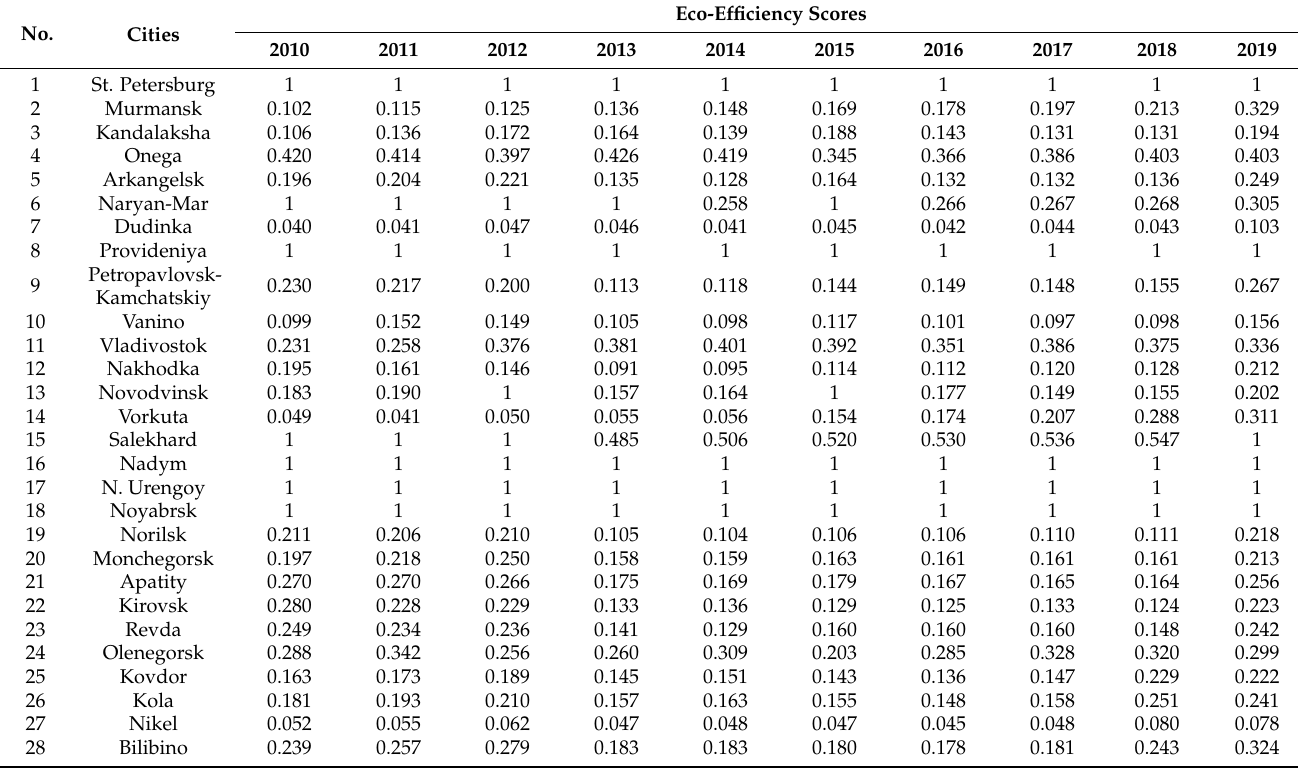
Table 3. Eco-efficiency scores of the cities along the NSR for